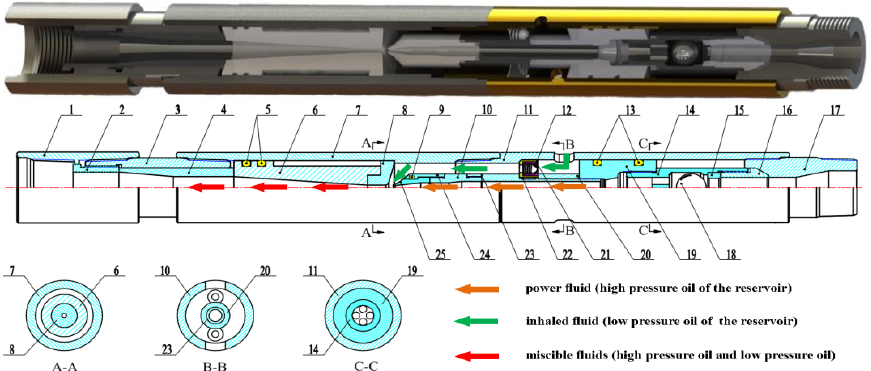
Figure 2. The structure and working principle of the new jet pump: 1. tubing clamp; 2. compression bolt; 3. tubing connector; 4. expanded pipe; 5. seal ring A; 6. diffuser tube; 7. pump housing; 8. throat; 9. seal ring B; 10. center connector; 11. joint of pump housing; 12. valve disk; 13. seal ring C; 14. check valve block; 15. check valve seat; 16. seat gland; 17. tail tube; 18. steel ball; 19. joint pipe; 20. sleeve; 21. check valve with spring; 22. straight pin; 23. joint of valve disk; 24. nozzle holder; 25. nozzle holder.